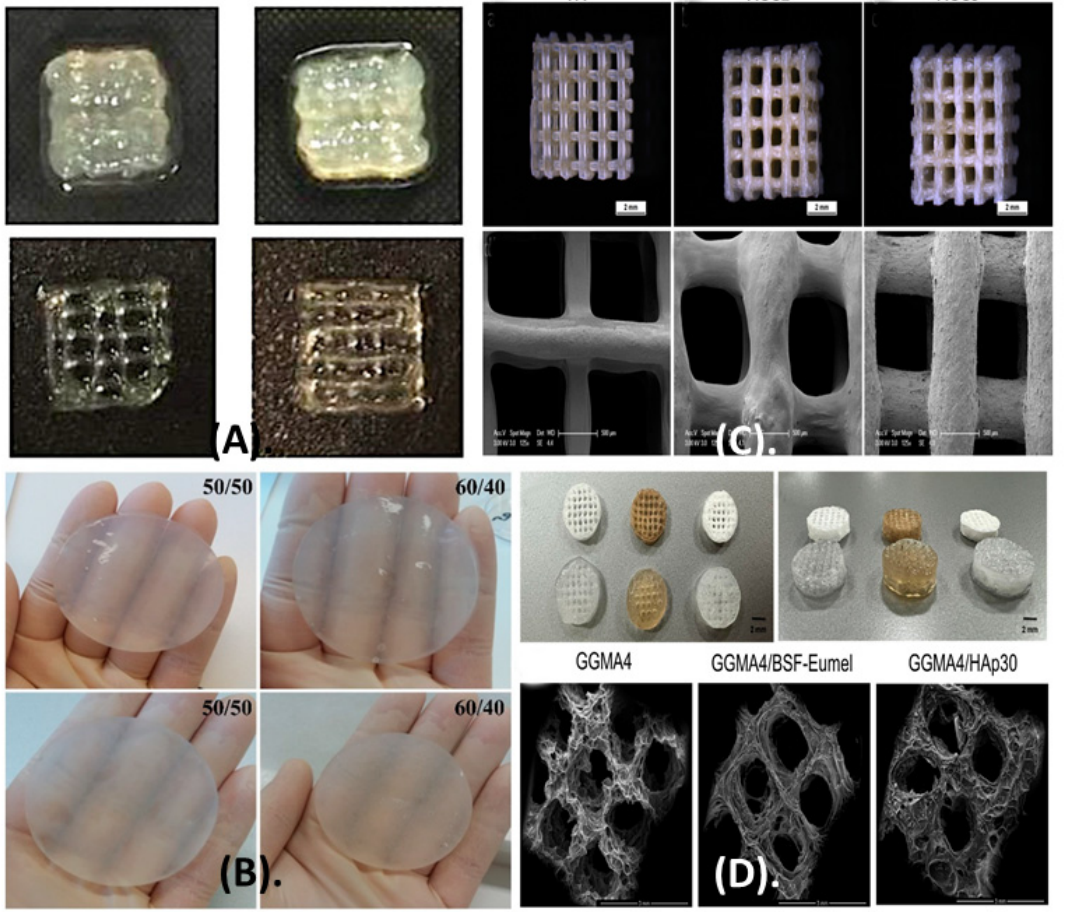
Figure 3. Composite scaffold prepared from different exopolysaccharides ( A ). Xanthan gum–gelatin [51]; ( B ). Xanthan gum–Konjac glucomannan [52]; ( C ). Alginate–gellan gum composites [53] and ( D ). Composite methacrylated gellan gum [54].